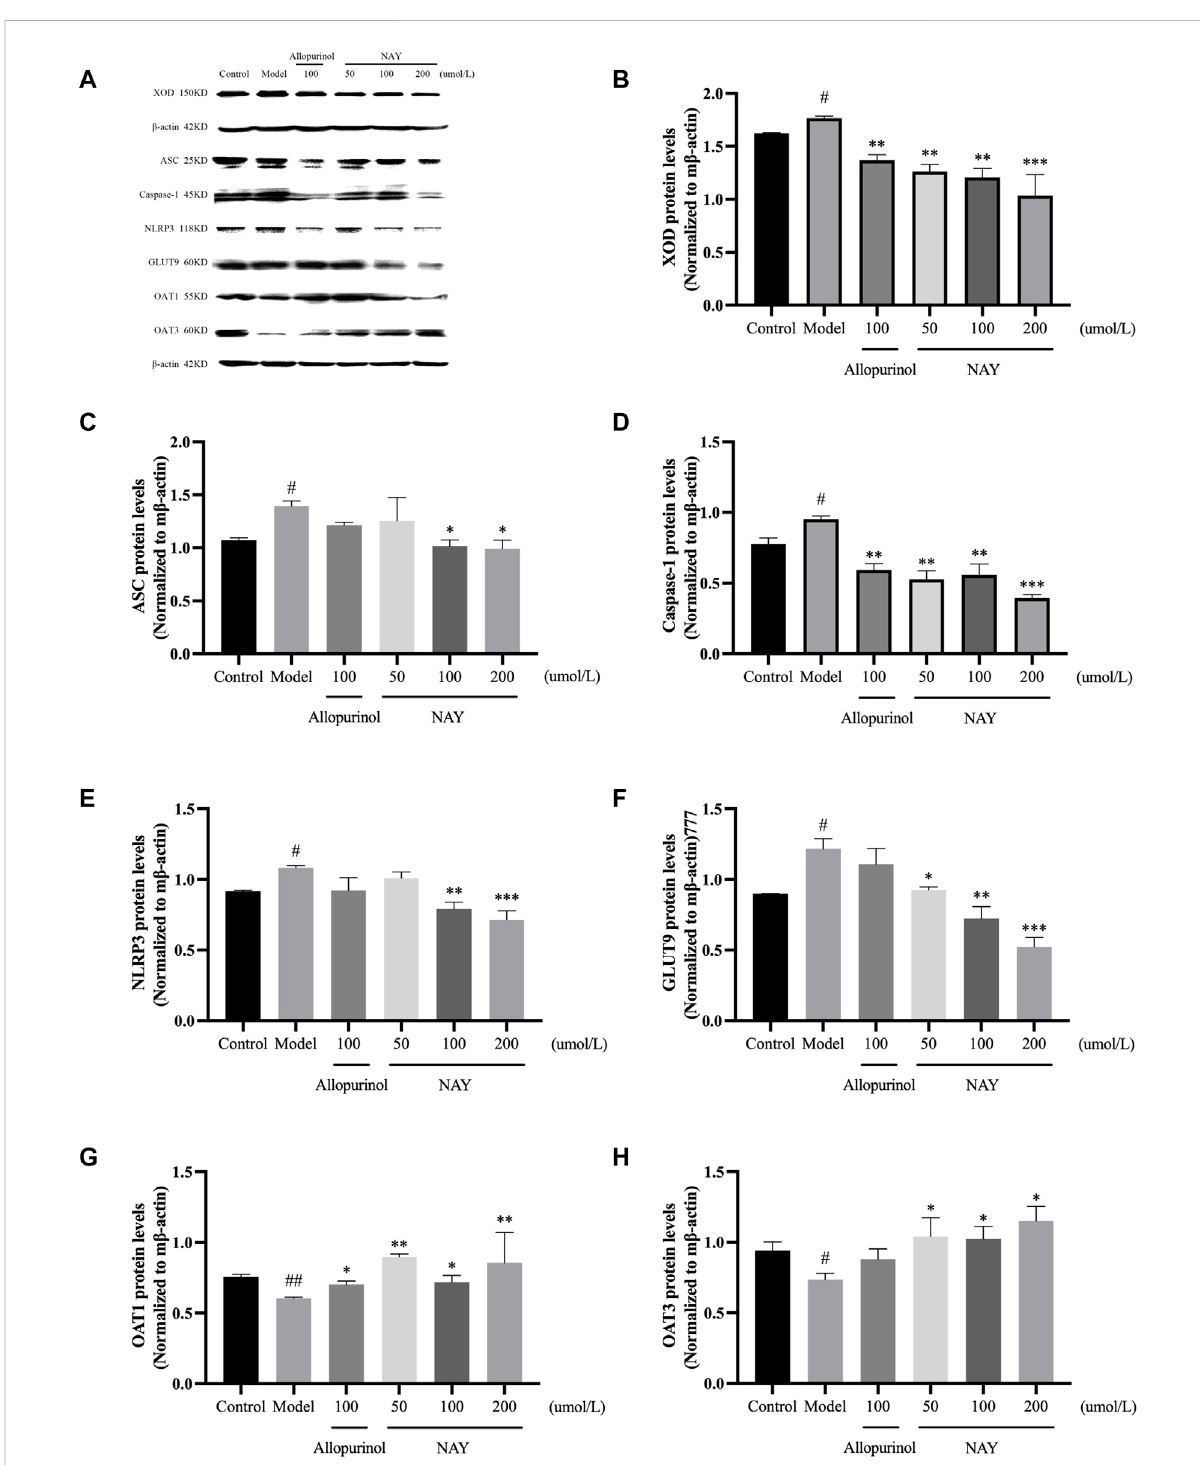
FIGURE 12 Effects of NAY and positive control on protein expression of XOD in AML12 cells and ASC, Caspase-1, NLRP3, GLUT9, OAT1, and OAT3 in HK-2 cells (A) . Data were normalized to β -actin (B – H) . (Data were expressed as mean ± S.E.M., n = 3. Compared with the control group, # P < 0.05, ## P < 0.01, and ### P < 0.001. Compared with the model group, * P < 0.05, ** P < 0.01, and *** P <